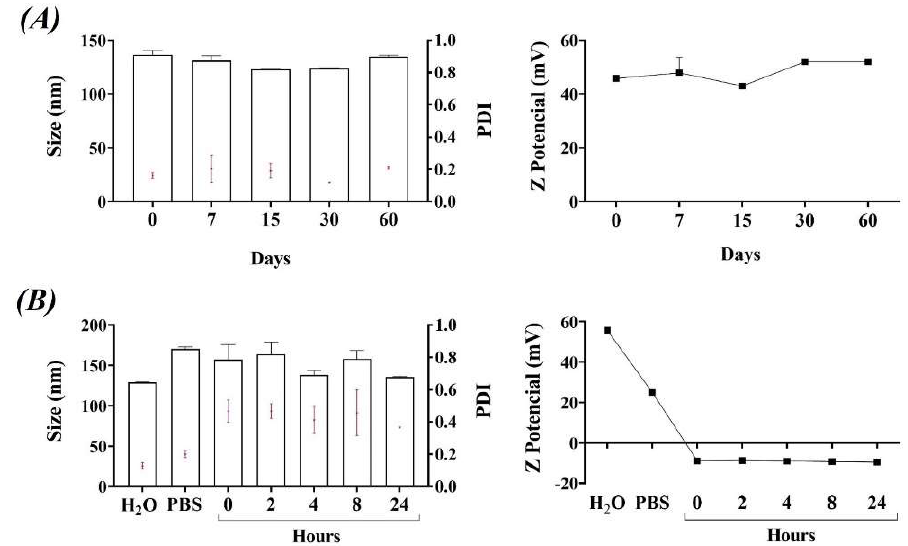
Figure 1. Stability characterization of DODAB:MO (1:2) liposomes. ( A ) Physicochemical character-